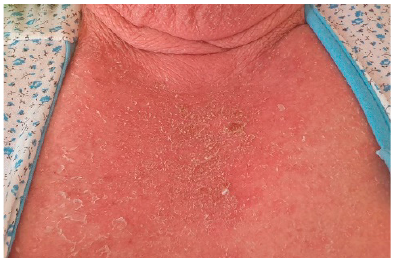
Figure 3. Erythematous skin rash with lamellar desquamation.